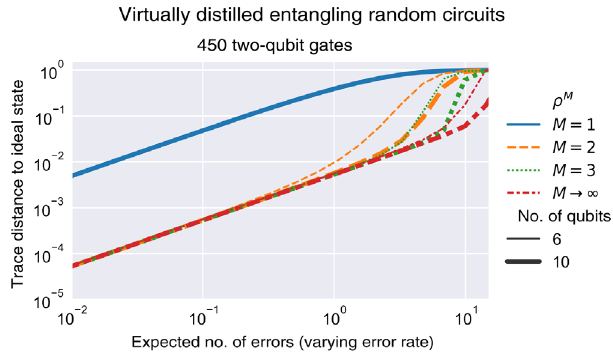
FIG. 14. The error in the unmitigated noisy states ( M ¼ 1 ), the states accessed by virtual distillation ( M ¼ 2 , 3), and the dominant eigenvector of the density matrices ( M → ∞ ) for a variety of entangling random circuits (described in Sec. IVA). We plot the trace distance to the state obtained from noiseless evolution as a function of the expected number of single-qubit amplitude-damping and dephasing errors, for six- and ten-qubit systems (demarcated by the thickness of the symbols). We vary the expected number of errors by varying the error rate per gate, fixing the number of two-qubit gates to be 450. This figure is constructed to parallel Fig. 6, except that we consider an error model based on single-qubit amplitude damping and dephasing rather than a depolarizing channel. We see that the system size dependence vanishes at low error rates in this case, in contrast with the data from Fig.